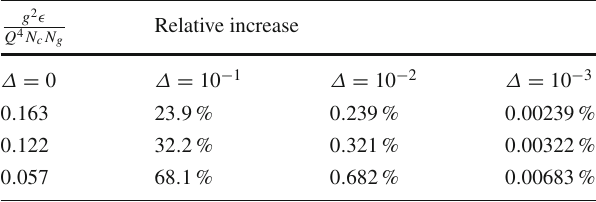
Fig. 8 Pressure ratio in the static box for different longitudinal lattice extents N z (top) and for different fluctuation amplitudes Δ (bottom) Table 1 The initial total energy density and its relative increase due to the fluctuations for different cutoff setups. First row: no additional cutoff, second row: m / Q = 0 . 1, third row: m / Q = 0 . 1 and Λ/ Q = 1 . 7. The statistical errors are all below the 1%-level